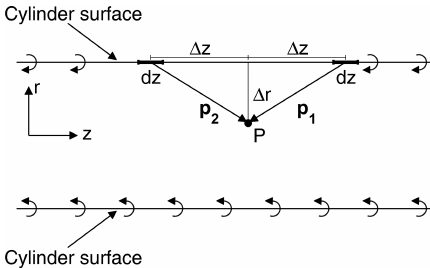
Figure A2. A 2D cut of the extruded vortex surface with definition of vectors p 1 and p 2 .